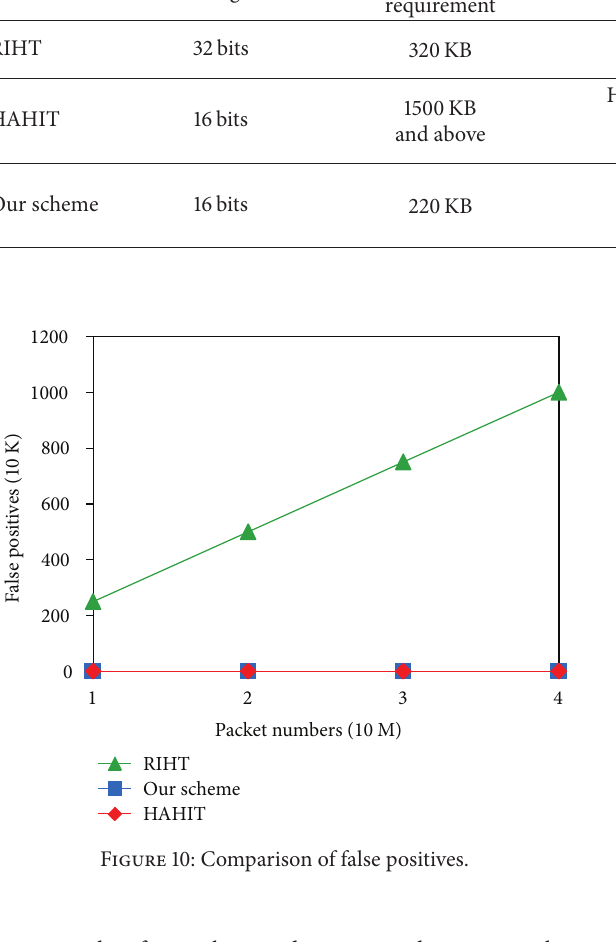
(⋅) : A hash function with hashed value table ranging from 0 to 𝑛 − 1 , where 𝑛 denotes the number of log